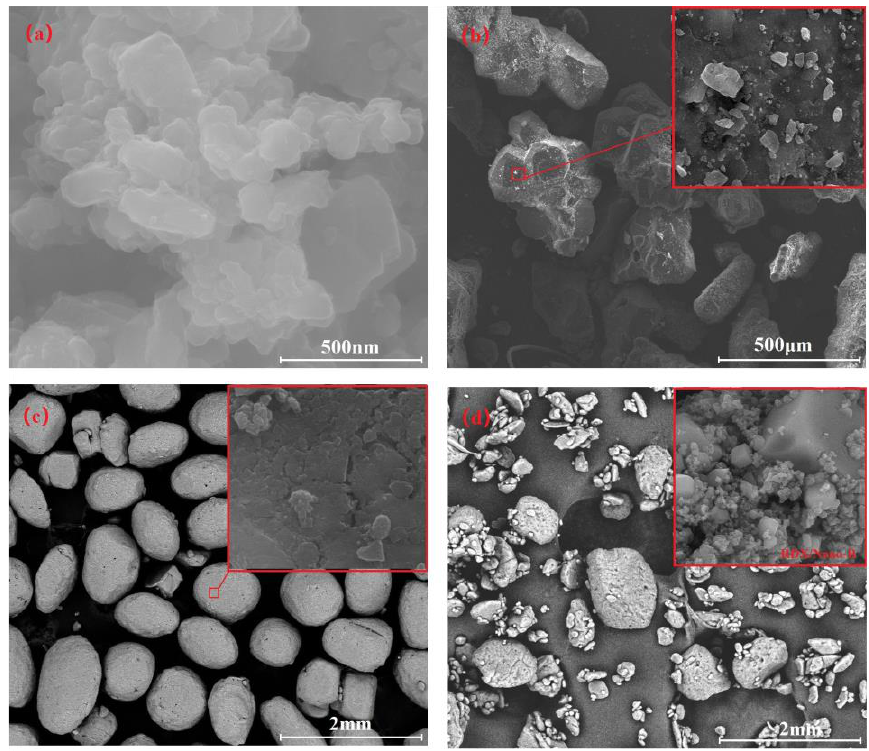
Figure 3. SEM morphology of Nano-B ( a ), RDX@Nano-B composites ( b ), PBX-B1 ( c ), and PBX-B2 ( d ) explosives.